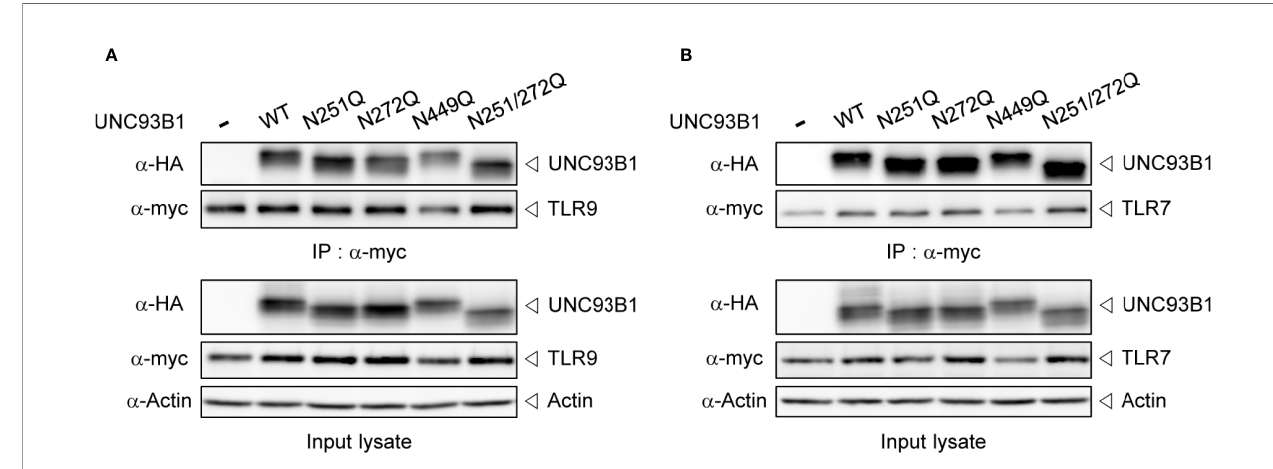
FIGURE 3 | Interaction between UNC93B1 and nucleotide-sensing TLRs is not affected by N-glycosylation of UNC93B1. Wild type or mutant UNC93B1-HA were expressed in HEK293T cells together with TLR9-myc (A) or TLR7-myc (B) . After immunoprecipitation of TLRs with anti-myc antibody, TLRs and TLR-associated UNC93B1 in the immunoprecipitates was detected with anti-myc and anti-HA antibody, respectively (upper two panels). Expression levels of UNC93B1, TLRs, and actin in the cell lysates were probed with anti-HA, anti-myc, and anti-actin antibody, respectively (lower three